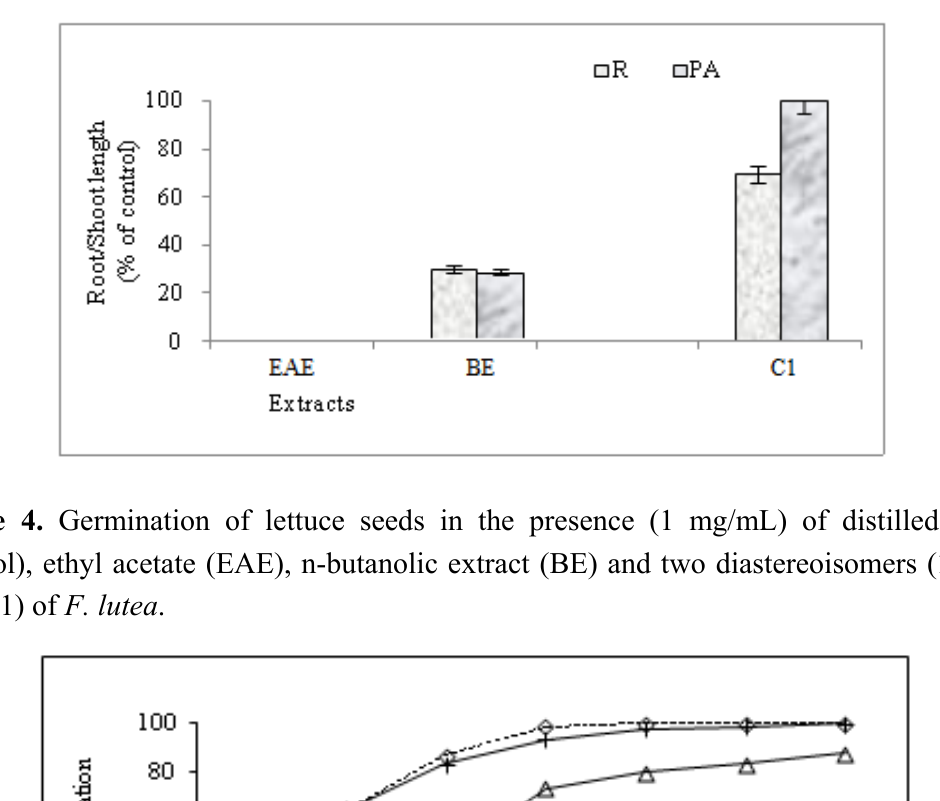
1b ) (C1) of F. lutea ; 7 days after germination.